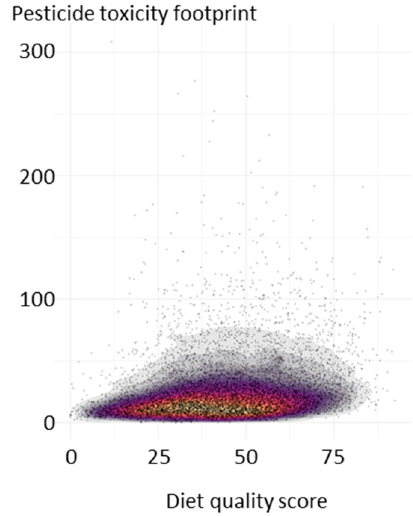
Figure 2. Pesticide toxicity footprint (points) and diet quality score (range 0–100). Scatterplot showing the diversity in the adult daily diets reported in the Australian Health Survey ( n = 9341). Shading indicates the density of the points from high (yellow) to low (grey). Table 2. Food intake (servings person − 1 ) and pesticide toxicity footprint (PTF, points per person − 1 ) for the average daily diet of 19–50-year-old Australian adults ( n = 5157) and a higher diet quality and lower pesticide toxicity footprint subgroup ( n = 1677) identified by the quadrant analysis. See the text for details. Food groups are as defined by the Australian Dietary